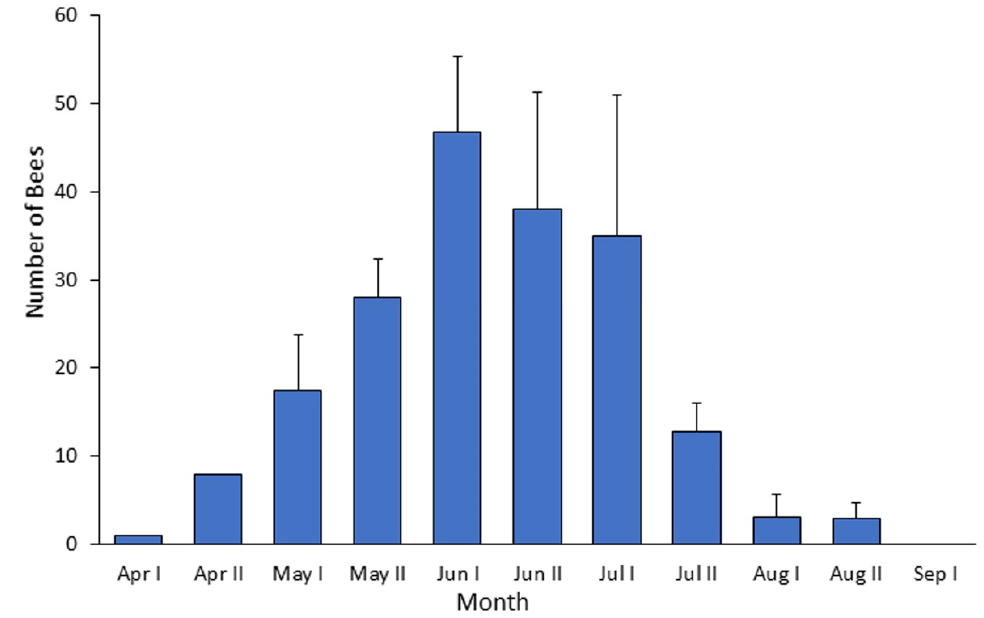
Figure 3. Mean number of Bombus terrestris records at the first transect after sunrise of each observa- tion day, during the period from April to September at Soreq site. Values are the averages for the three sampling years; error bars depict standard errors between years.